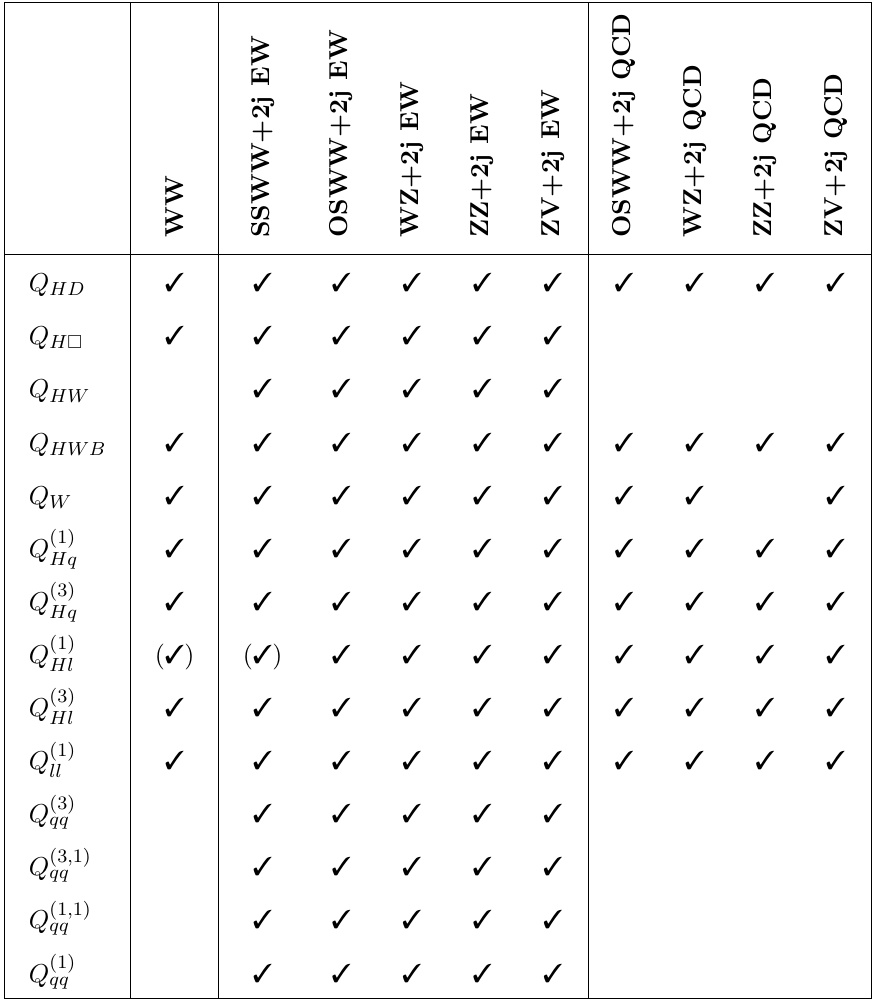
Table 3 . Summary table for the dependence of the processes under investigation on the 14 benchmark EFT operators. Empty cells indicate that there are no diagrams for that operator for a given process. The brackets indicate that the operator only enters non-resonant